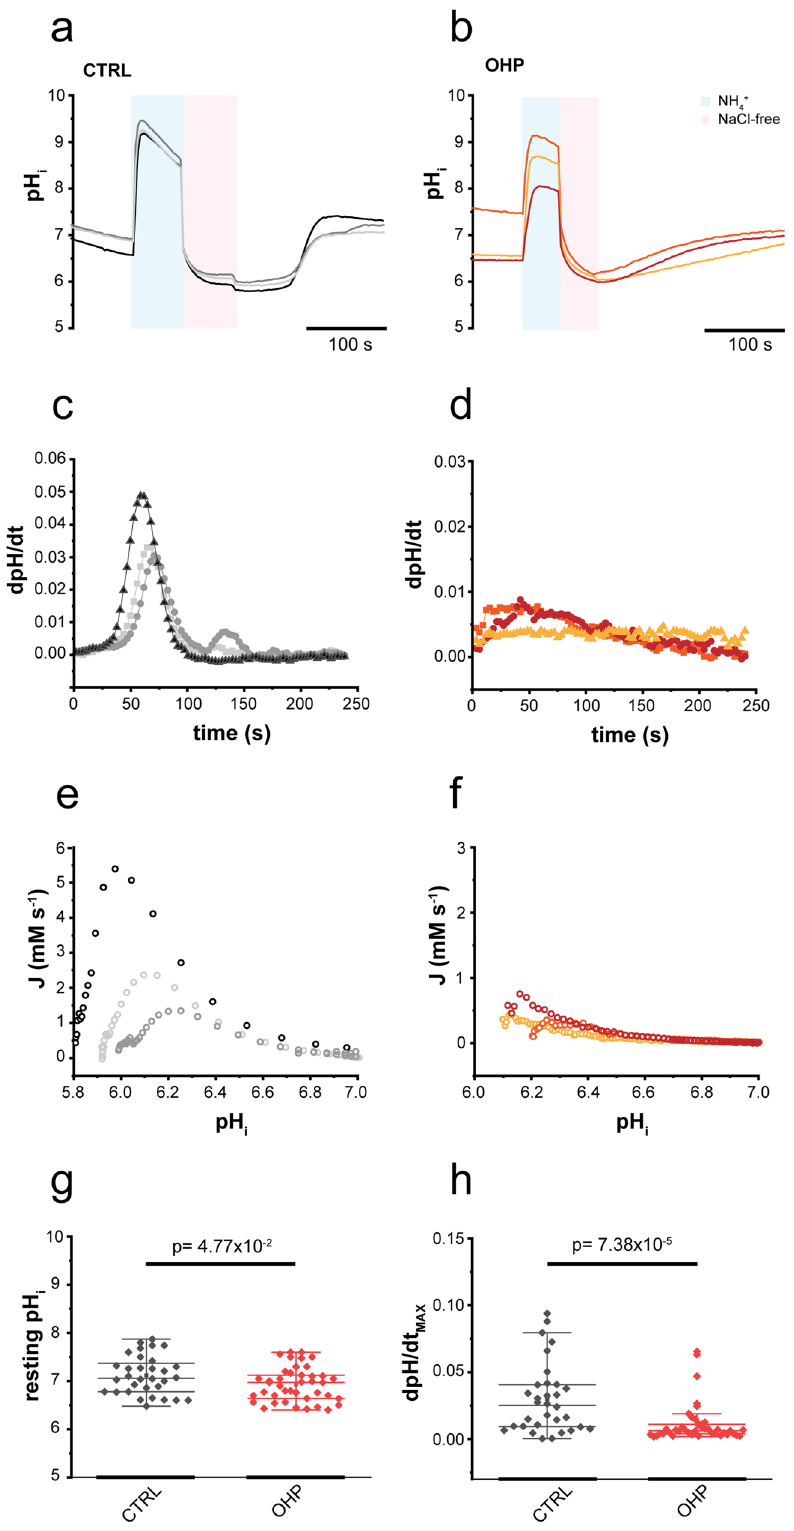
Figure 2. Effect of OHP on resting pH i and NHE1 activity. pH i recovery from an acid load in three untreated DRG neurons ( a ) and in neurons incubated for 1 h with 0.1 μg/ml of OHP ( b ). Panels ( c ) and ( d ) represent the instantaneous pH i rate of change versus time of traces in ( a ) and ( b ), which were used to compute the pH i dependence of the total acid extrusion J ( e , f ). Statistical plots (Mann–Whitney U test) compare control (black) and OHP-treated (red) resting pH i ( g ) and the maximum rate of recovery dpH/dt MAX ( h